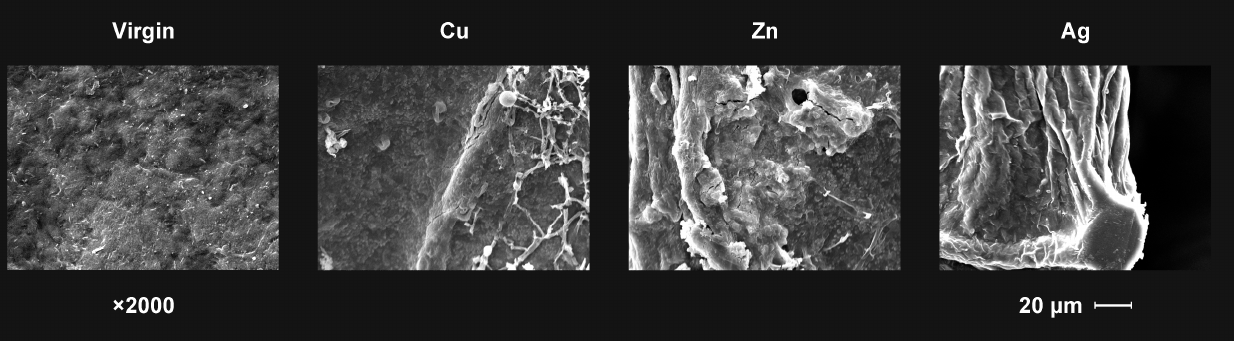
Figure 5. The SEM observation results of the virgin and the ion implanted bacterial cellulose surface after T. viride growth at day 5 in the test. after T. viride growth at day 5 in the